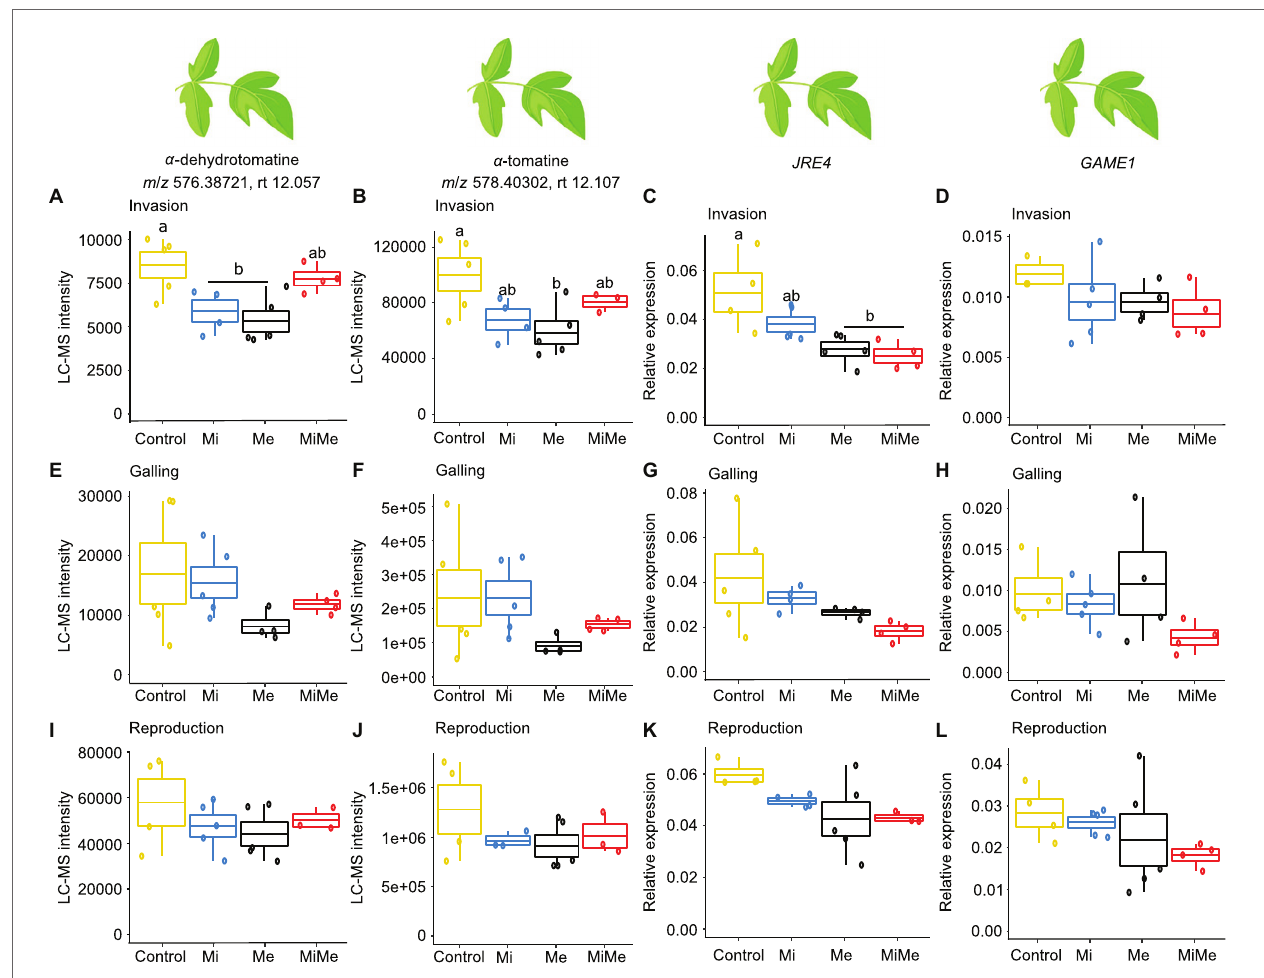
FIGURE 3 | Relative intensities of the m/z signals of the steroidal glycoalkaloids α -dehydrotomatine and α -tomatine and relative expression of glycoalkaloid-related metabolism genes jasmonate-responsive ethylene response factor 4 ( JRE4 ) and glycoalkaloid metabolism 1 ( GAME1 ) in tomato leaves upon aboveground and belowground herbivory. Mean LC-MS intensities of α -dehydrotomatine ( m/z 576.38721; rt. 12.057 min) and α -tomatine ( m/z 578.40302; rt. 12.107 min) and expression of JRE4 and GAME1 in leaves tomato plants infected belowground with Meloidogyne incognita (Mi), or infested aboveground with Macrosiphum euphorbiae (Me) or with both herbivores (MiMe). Control = plants without herbivores. Boxplots are the mean (±SEM, n = 5) of α -dehydrotomatine (A,E,I) , α -tomatine (B,F,J) , JRE4 (C,G,K) , and GAME1 (D,H,L) measured at the nematodes’ invasion (A-D) , galling (E-H) , or reproduction (I-L) stages. Different letters above the boxplots indicate significant ( p ≤ 0.05) differences in mean values between treatments, determined by Tukey's HSD test after ANOVA